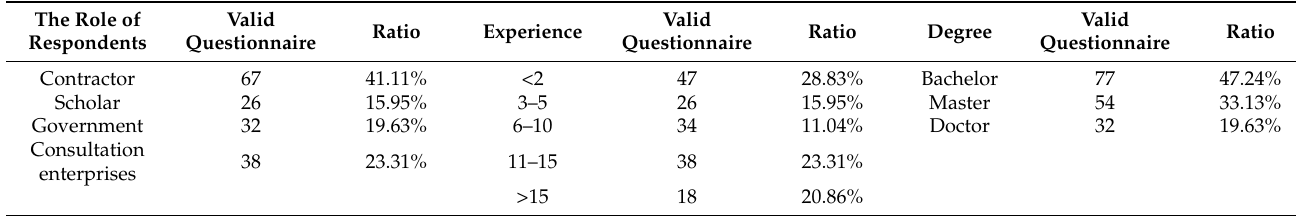
Table 2. The personal information of